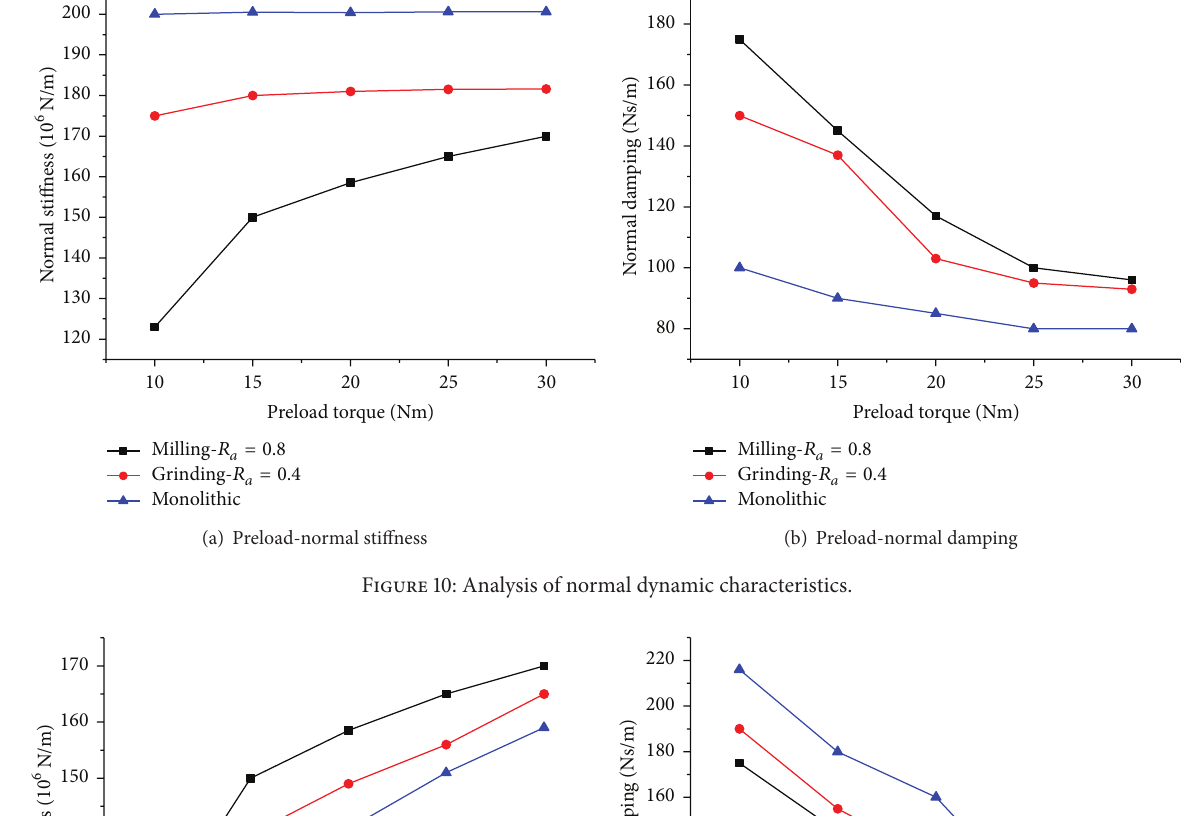
Figure 10: Analysis of normal dynamic characteristics.